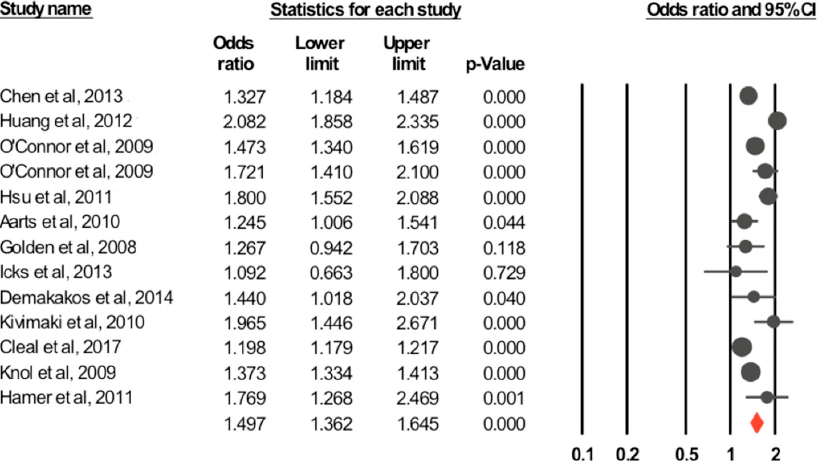
Figure 2. Forest plot for the association between depression and diabetes from cohort studies. Estimates are in the center of the box and lines represent 95% confidence intervals (CI). Diamond shows the pooled odds ratio size and its 95% CI.